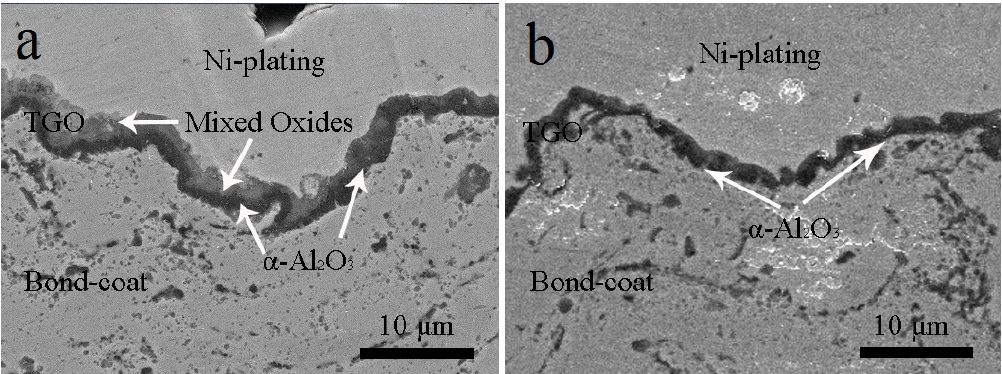
Figure 6. Cross-sectional morphology of bondcoat samples after oxidation for 5 h at 1200 °C ( a ) as-sprayed sample, ( b ) Al coated sample.